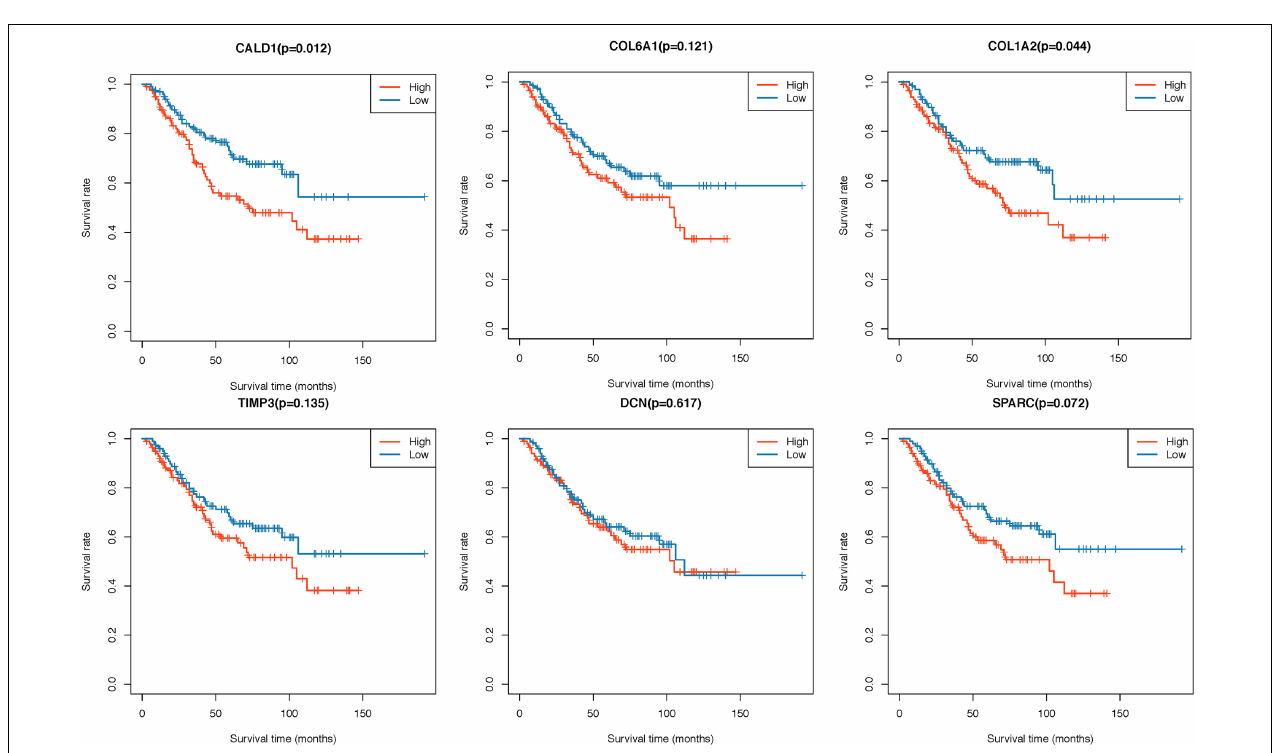
FIGURE 5 | Kaplan–Meier survival curves of six hub genes grouped by their median expression values in the GSE39582 dataset.